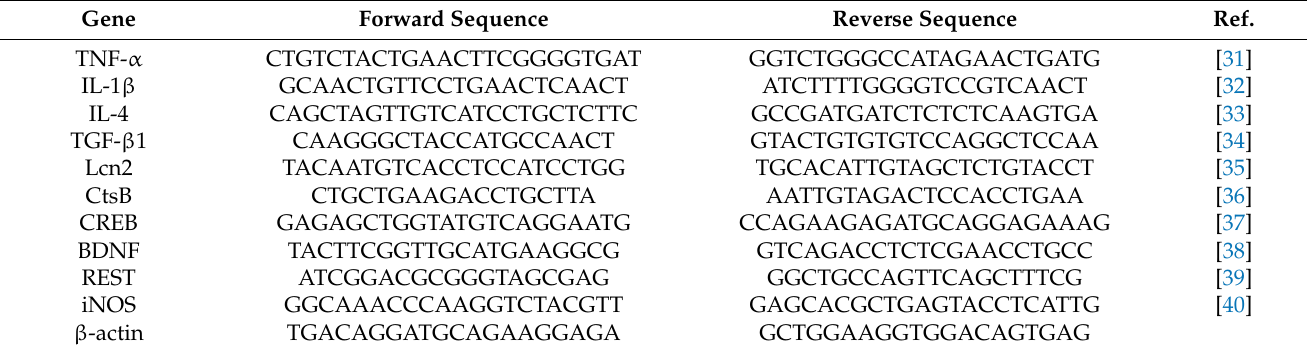
Table 2. CDNA derived from transcripts encoding β -actin was used as the internal control. Table 2. Sequence of primers used in the